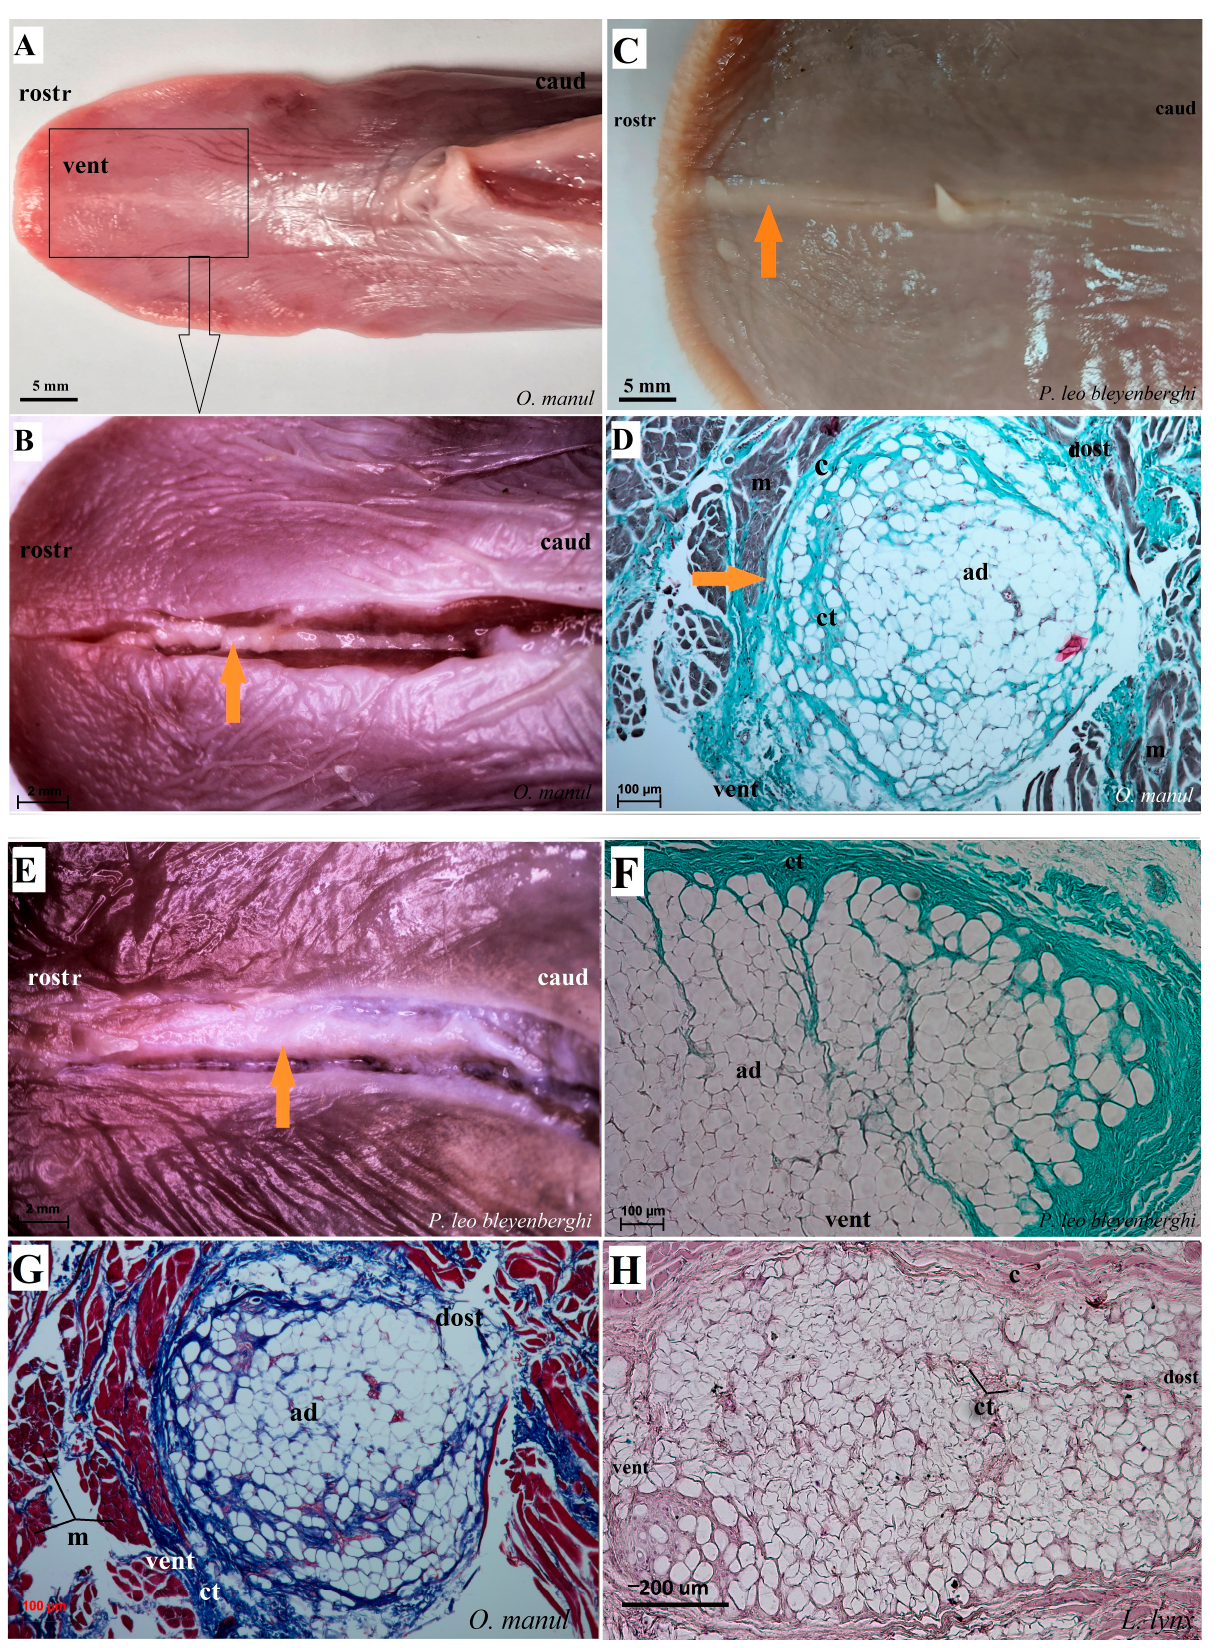
Figure 7. Macroscopic view ( A , B , C , E ) and histological examination ( D , F , G , H ) of the lyssa of O. manul ( A , B , D , G ), P. leo bleyenberghi ( C , E , F ) and L. lynx (H). ( A , C ) Ventral smooth surface of the tongue with lyssa (orange arrow). ( B ) Magnification (black rectangle) of the ventral surface of the